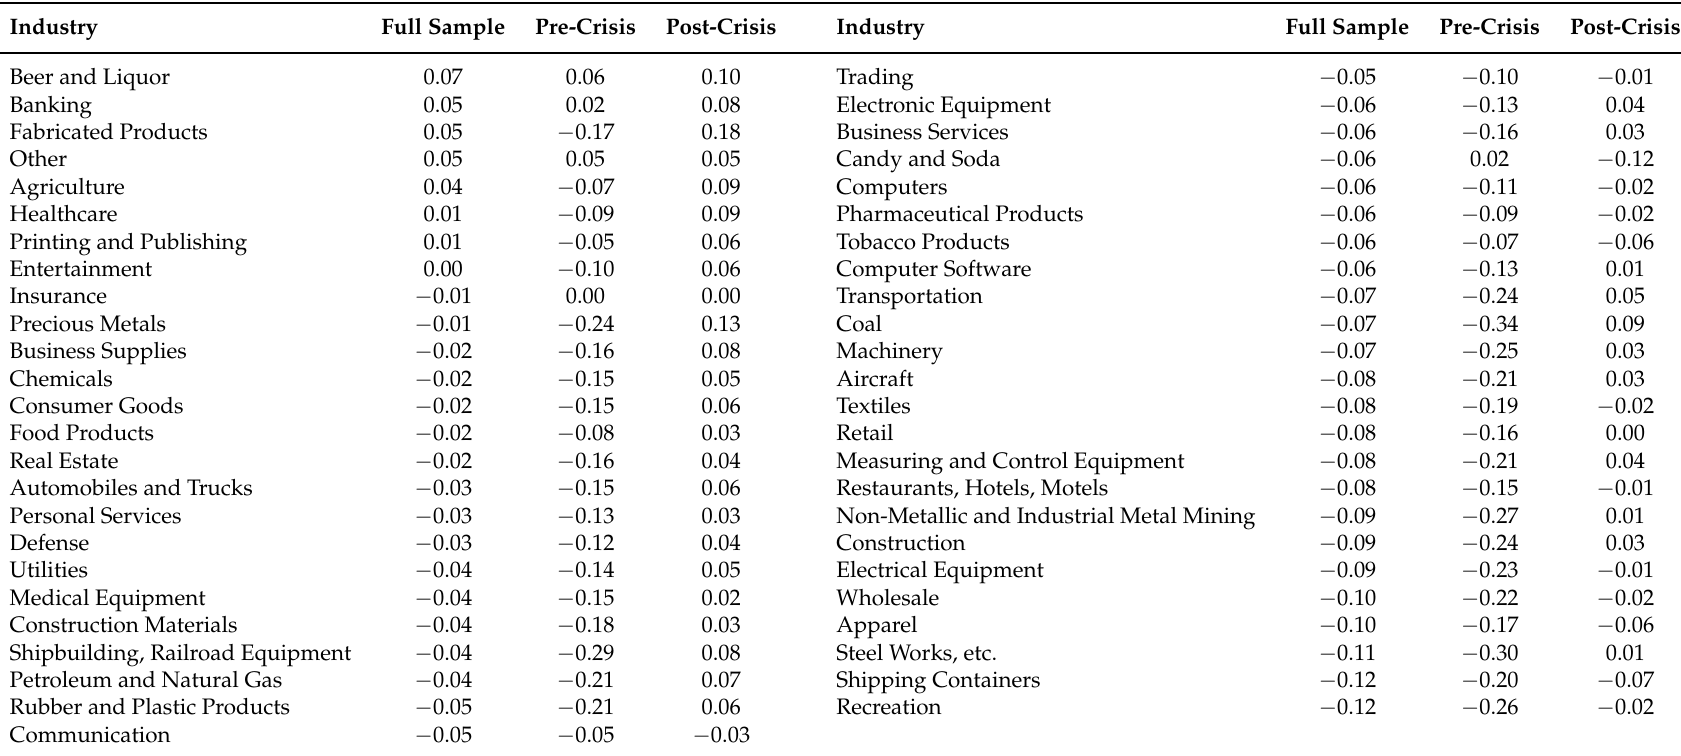
Table A2. The table reports the Pearson correlation between the impressionist art index and each of the Fama and French 49 industry groups over three time periods. Full sample refers to correlations computed using monthly data ranging from 2002:04 to 2017:09; pre-crisis correlations are computed using data ranging from 2002:04 to 2008:08; and post-crisis correlations are computed using data ranging from 2008:09 to